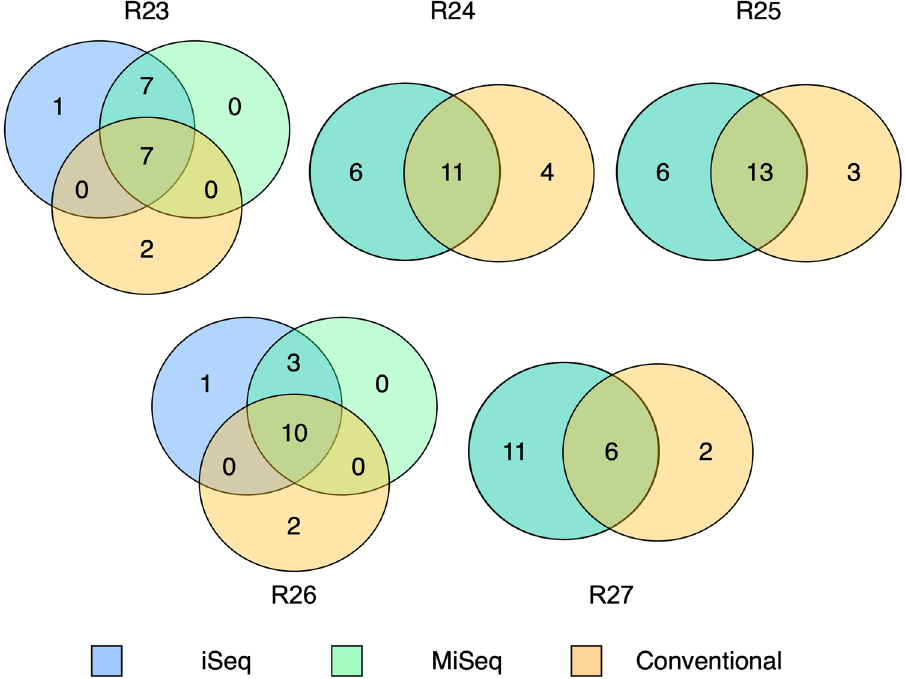
Figure 2. Venn diagrams for comparison of the number of species between high throughput sequencers and conventional methods in 5 river samples. Blue, green, and orange circles indicate the species of eDNA of iSeq, eDNA of MiSeq, and conventional methods, respectively. Deep green circles in R24, 25, and 27 indicate the species of two sequencers because of fully-overlapping species composition between iSeq and MiSeq. Note that the size of each circle does not represent a difference in the number of species. Figure was created using “venndiagram” package version 1.6.2 supported on R program software 44